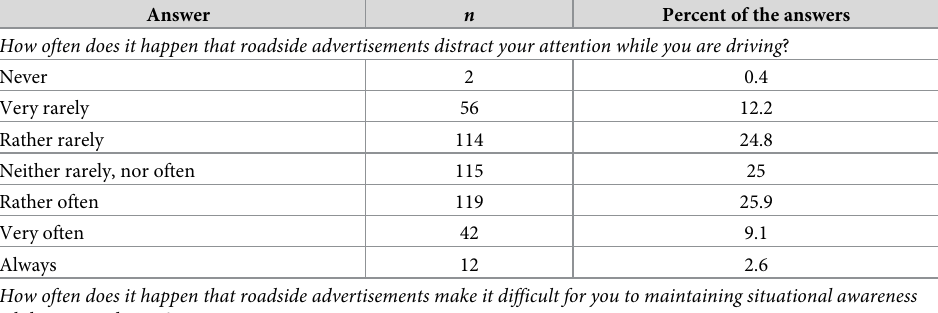
Table 1. Frequency analysis for questions related to experiences with roadside advertisements. Answer n Percent of the